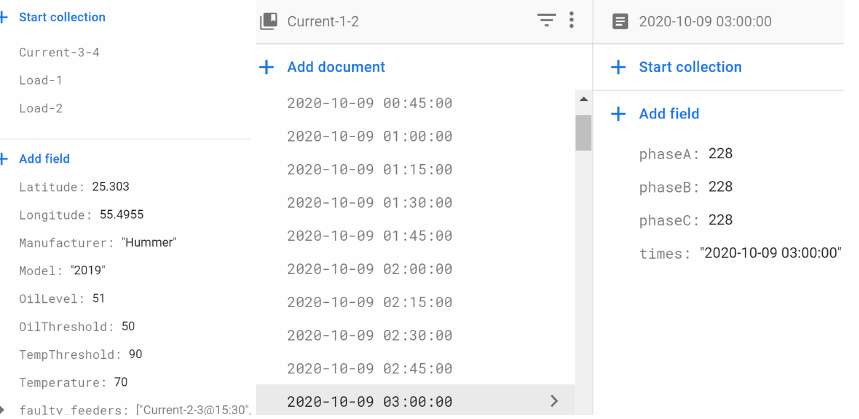
shown in Figure 4.